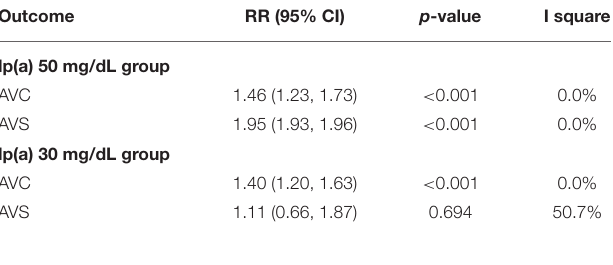
TABLE 3 | The meta-analyses for the associations of lp(a) with AVC and AVS. Outcome RR (95% CI) p -value I square